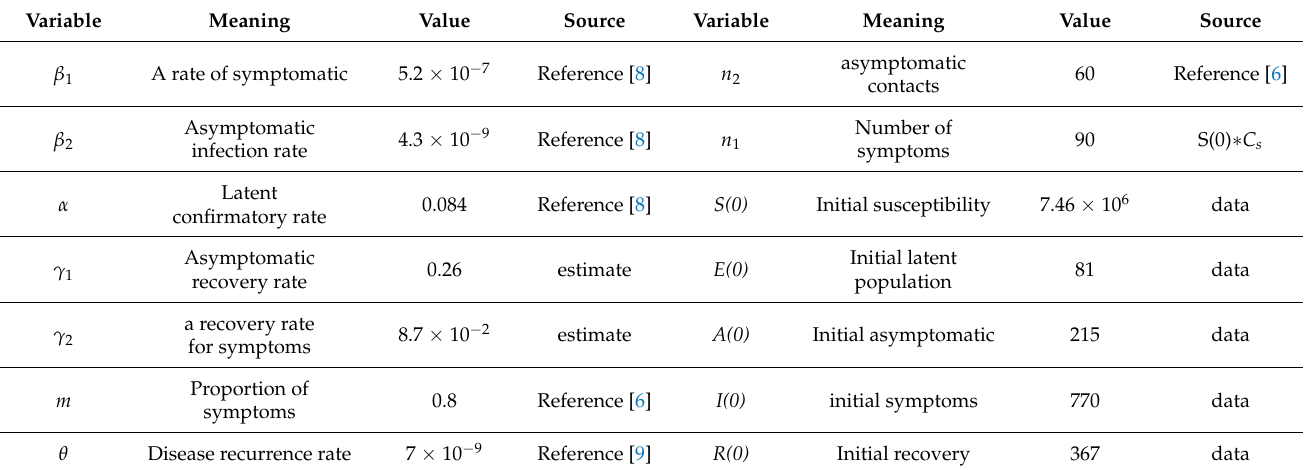
Table 2. Initial conditions and parameter values of the SEIARN model.